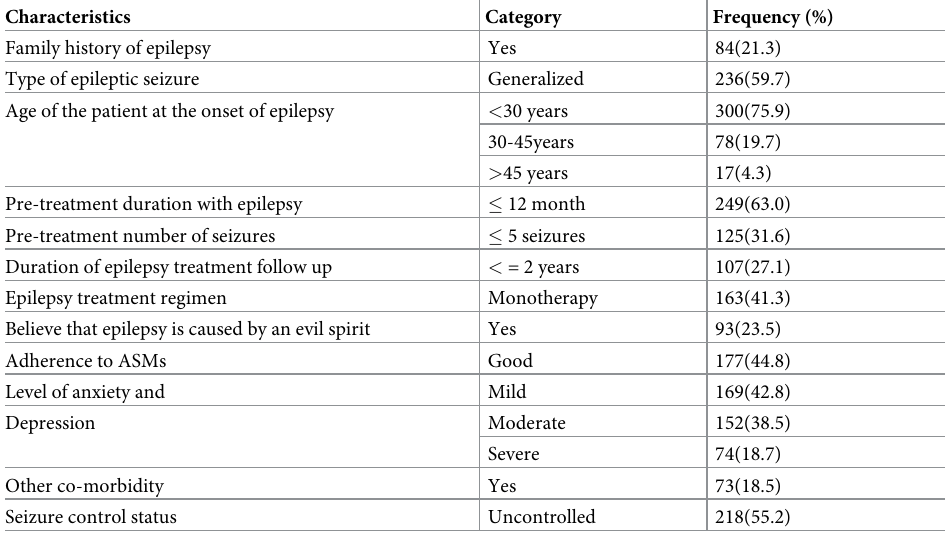
Table 2. Clinical characteristics of epileptic patients ( n =